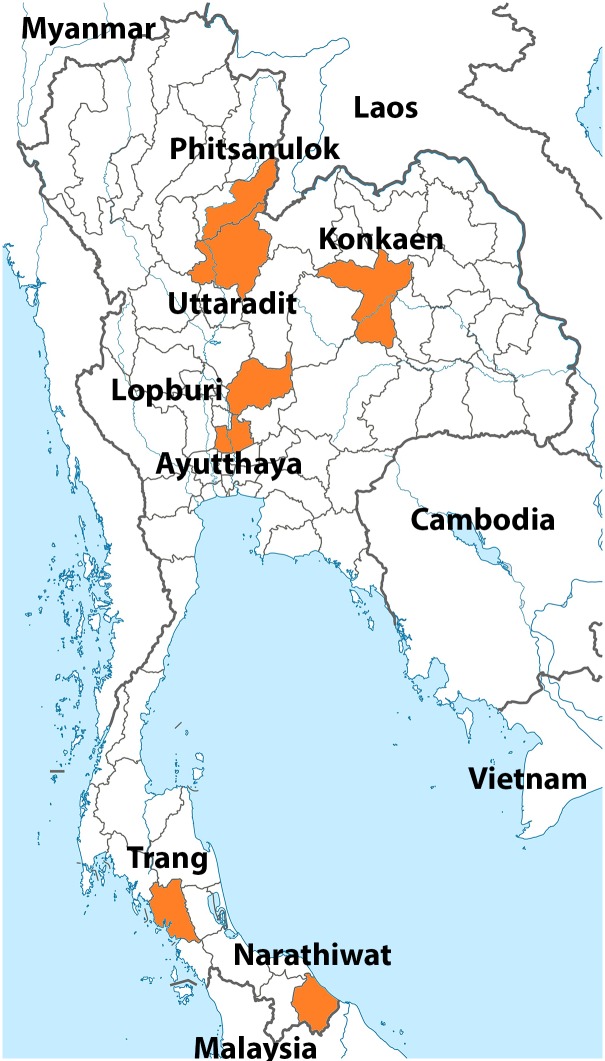
Map of Thailand showing the seven provinces in this study.Uttaradit and Phitsanulok represent the northern provinces; Lop Buri and Ayutthaya represent the central provinces; Trang and Narathiwat represent the southern provinces; and Khon Kaen represents a northeastern province (all denoted in orange).